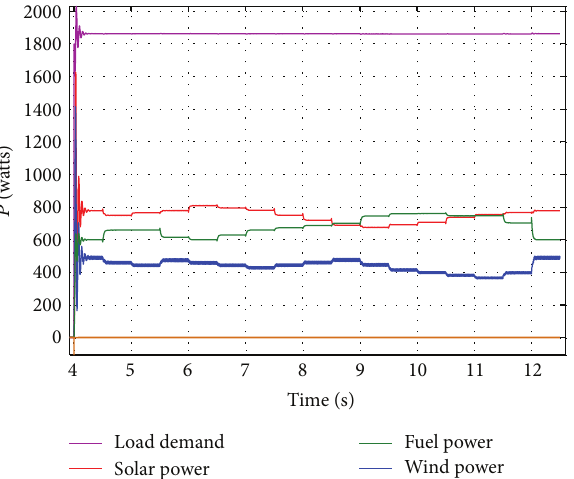
Figure22:SolarPVpanel,WTG,andbatterysupplyLD,andbattery charges with surplus power at PCC.